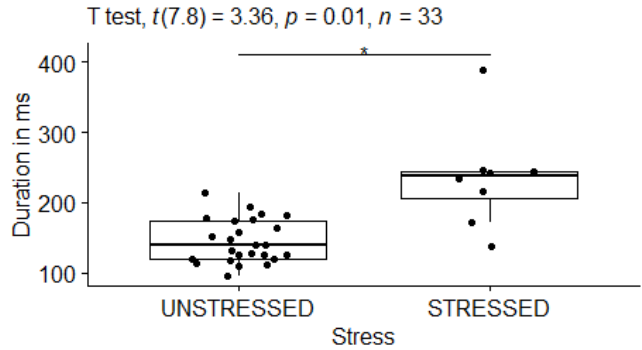
Figure 4. Boxplot for Duration grouped by stress.